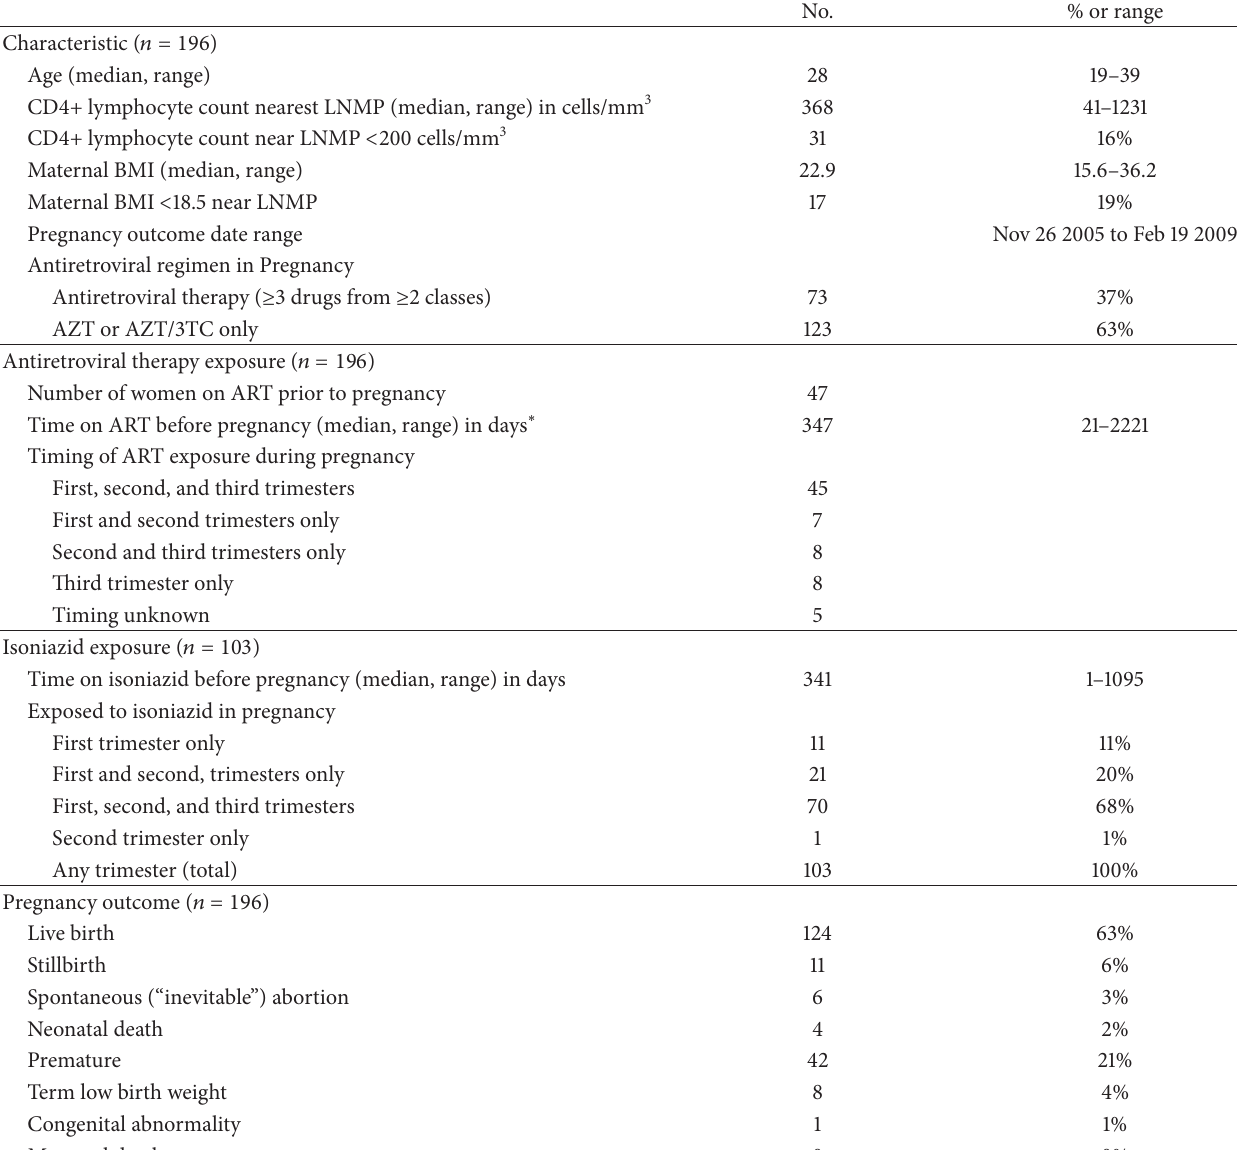
Table 1: Selected characteristics of subjects experiencing pregnancy during the Isoniazid Preventive Therapy Trial, Botswana, 2005–2008 ( 𝑛 = 196 ).